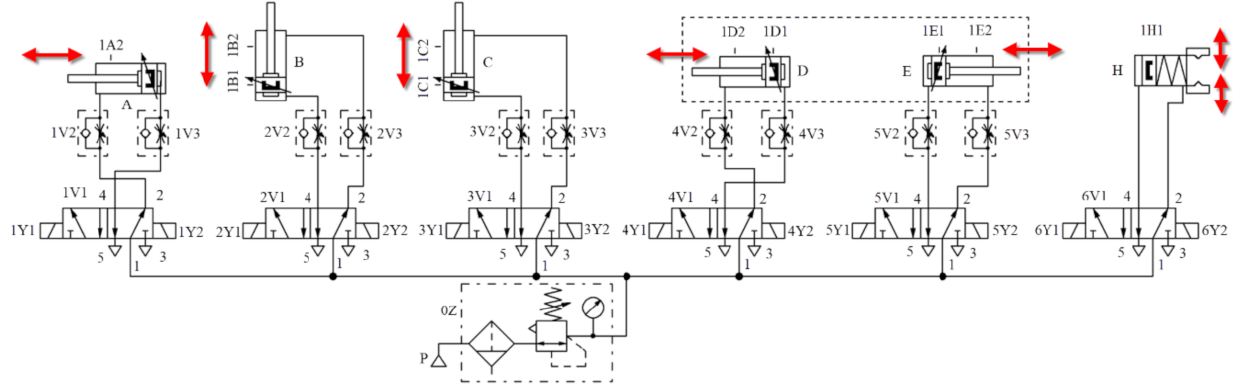
Figure 3. Initial pneumatic control scheme of the